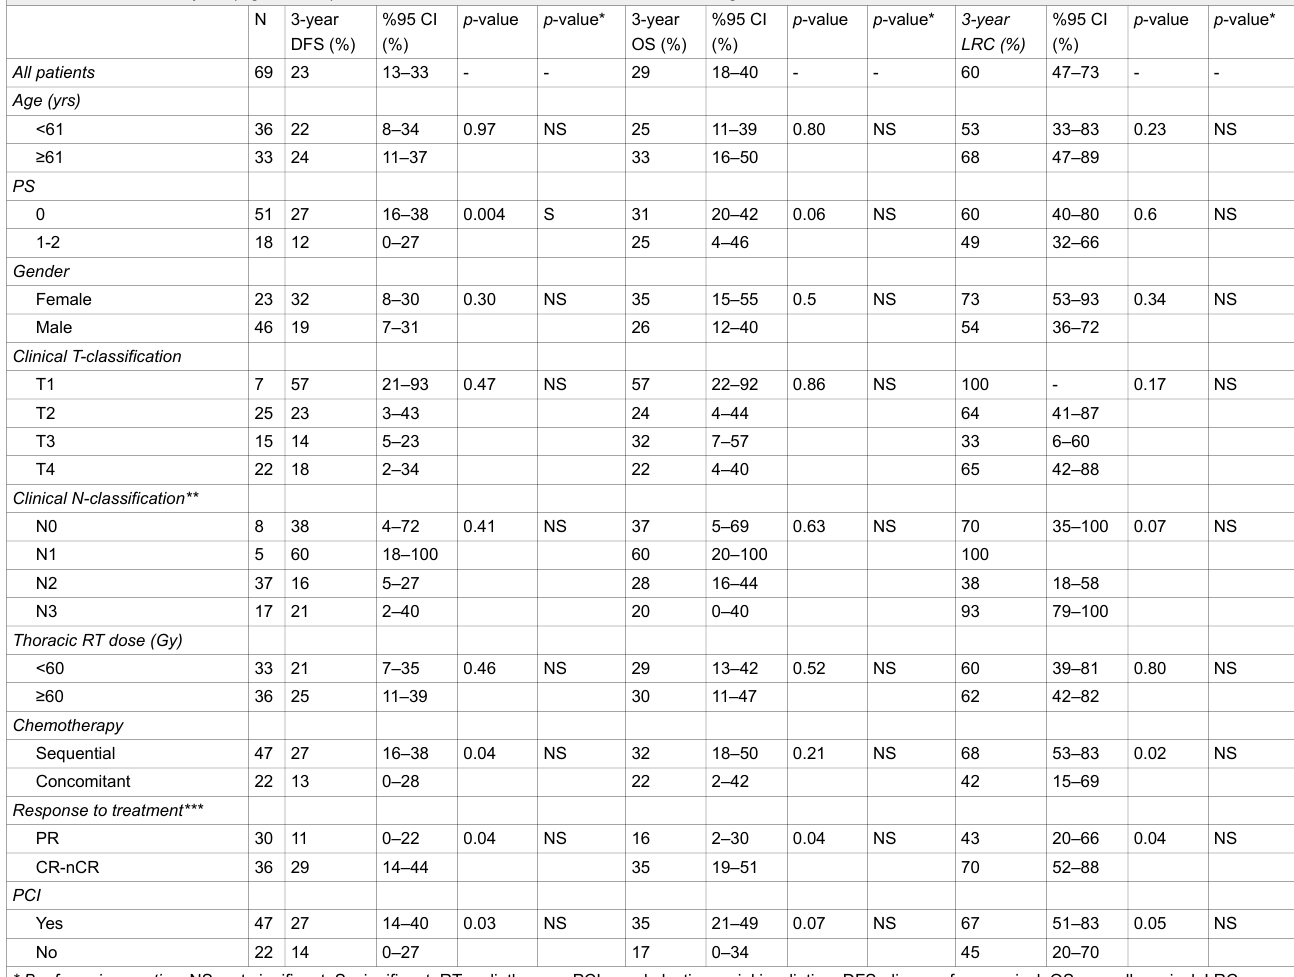
Table 3: Univariate analyses (log-rank test) on disease-free survival, overall survival and loco-regional control. N 3-year DFS